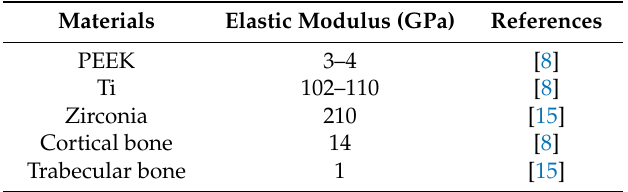
Figure 1. ( a ) Clinical applications of PEEK; Fused deposition modeling (FDM)‐printed PEEK ( b ) breastbone and ( c ) nasal reconstructions. Table 1. The elastic modulus of different materials and human tissues.